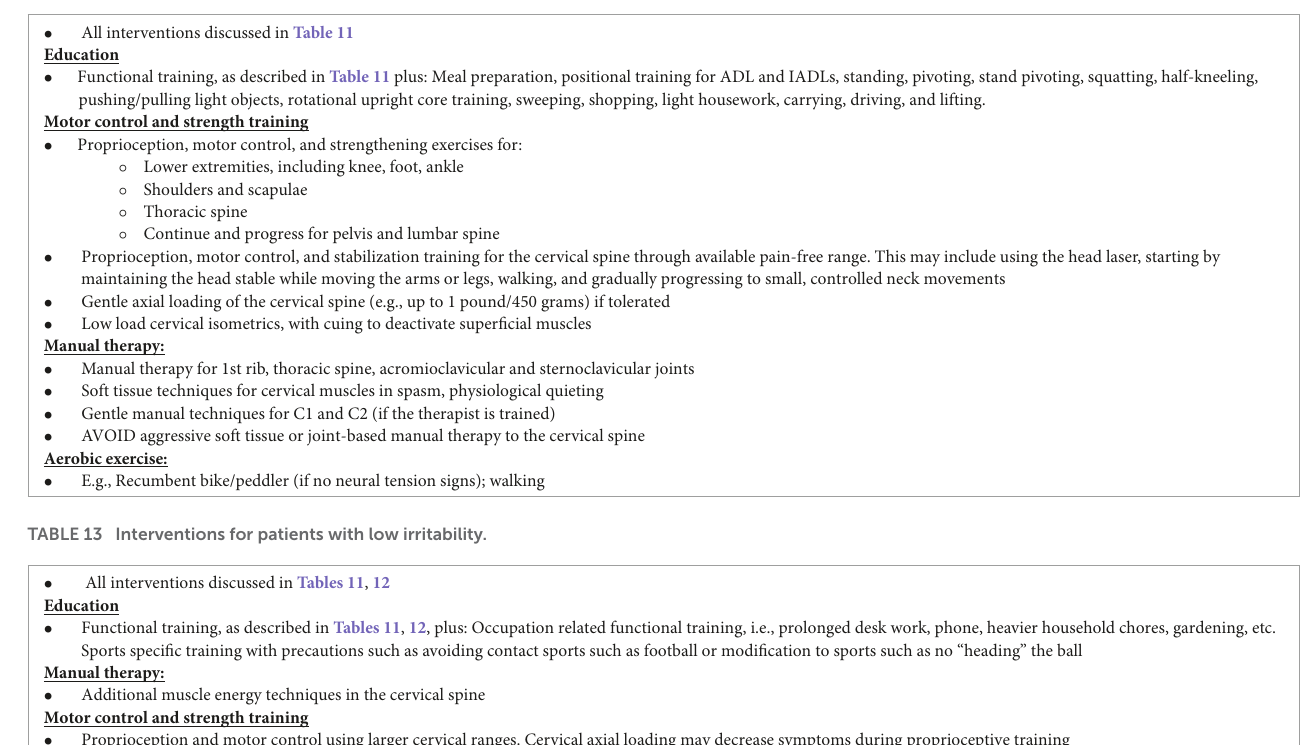
TABLE 12 Interventions for patients with moderate